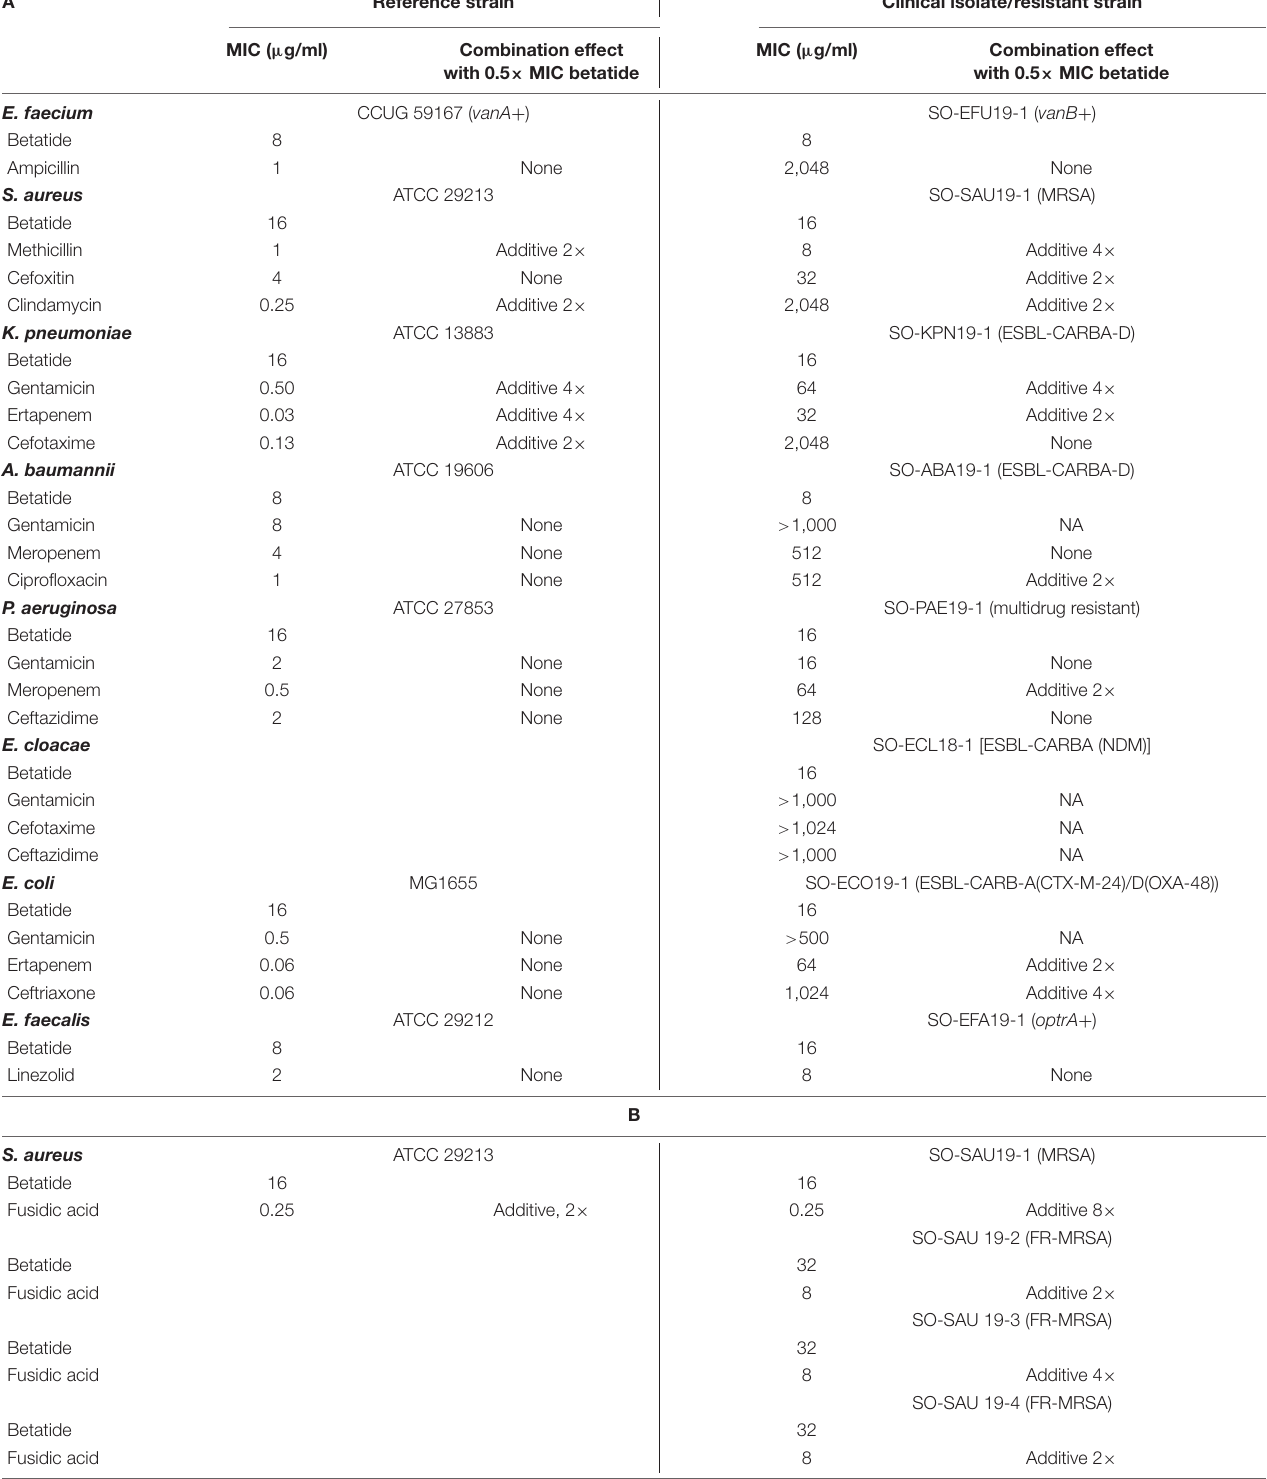
TABLE 3 | MIC values and combination effects of betatide and commercial antibiotics in (A) ESKAPE strains and (B) Staphylococcus aureus fusidic acid sensitive (MRSA) and resistant (FR-MRSA).